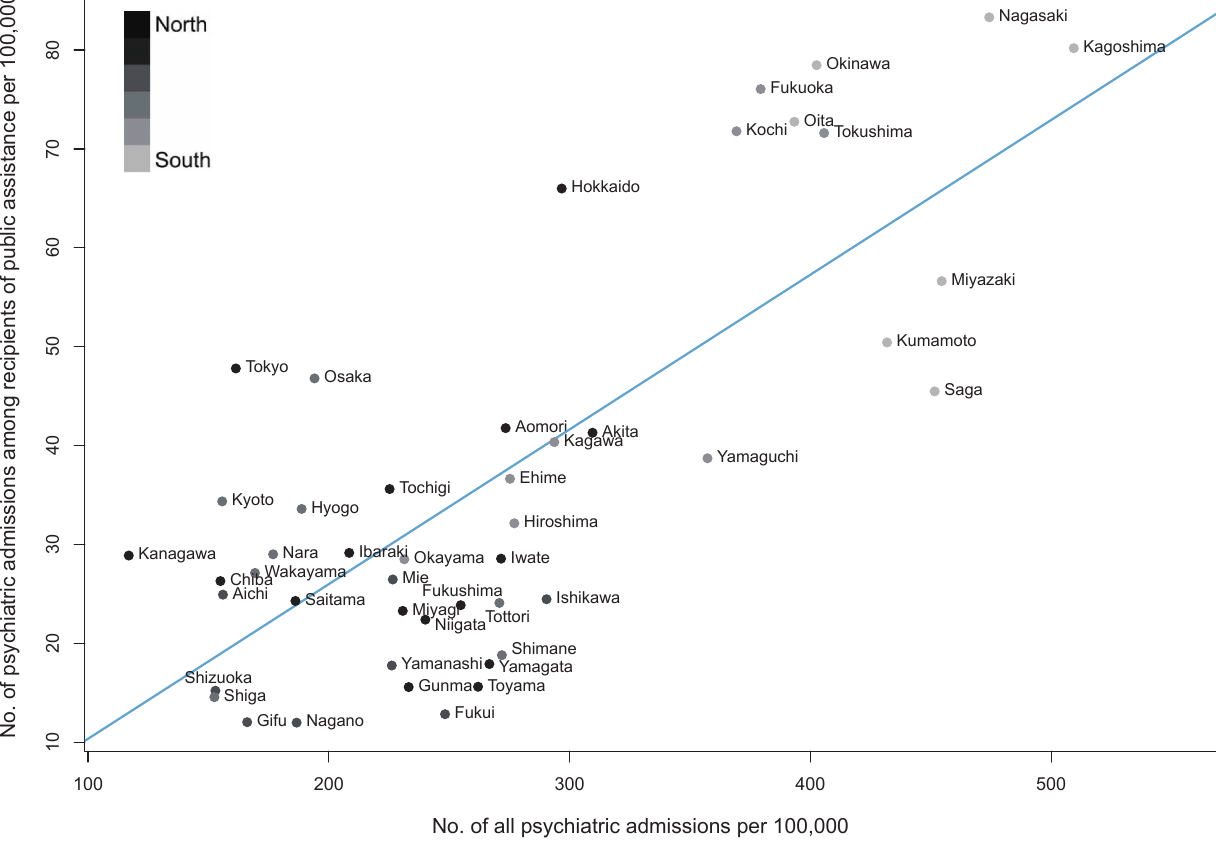
Figure 4. Scatterplot of the age- and sex-standardized number of psychiatric admissions among recipients of public assistance per 100,000 population vs the age- and sex-standardized number of all psychiatric admissions per 100,000